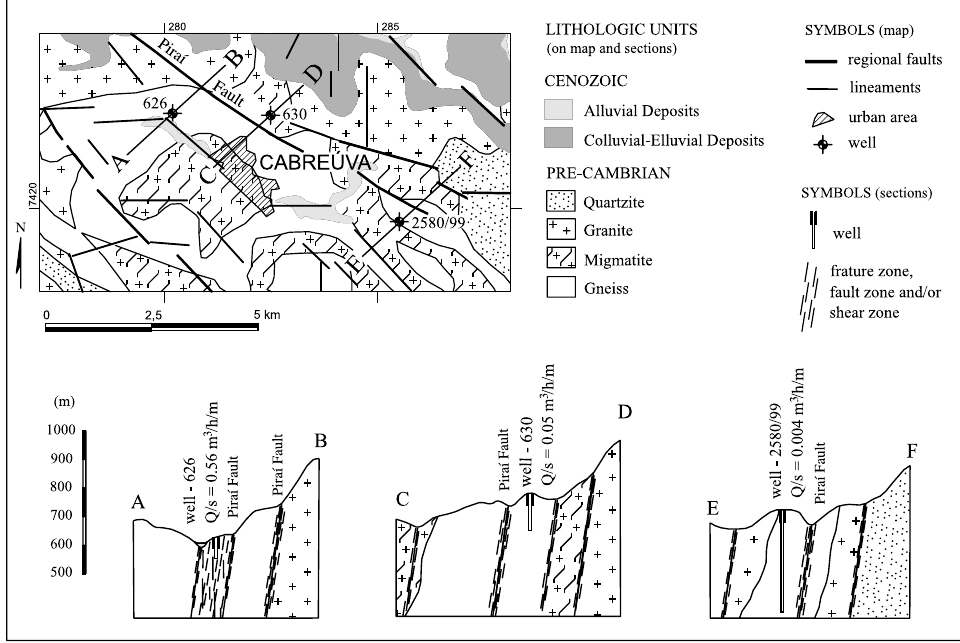
Fig. 8– ThecasestudyofCabreúvaCounty, wherethereiscontrolbyNW–SEandE–Wstructuresinwellproductivity.